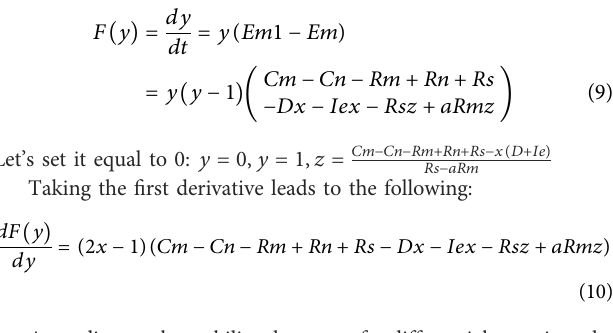
(Figure 3A, then F ( y ) ≡ 0. This (cid:6)(cid:6) (cid:6) (cid:6) < 0, At this (Figure 3B), then dF ( y ) dy x (cid:2) 0 (cid:6)(cid:6)(cid:6)(cid:6) > 0, At this (Figure 3C), then dF ( y ) dy x (cid:2) 0